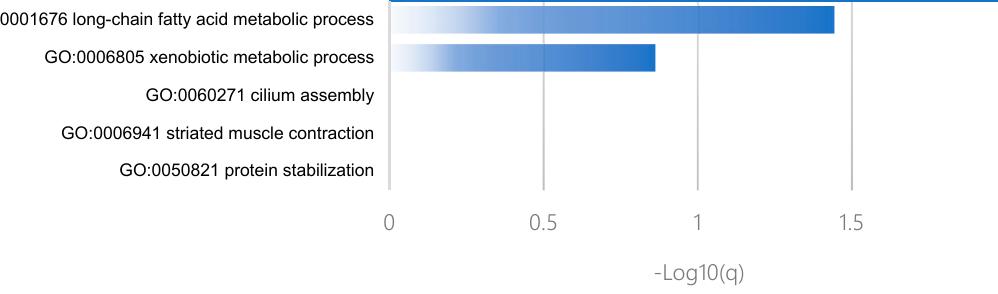
Figure 4. Gene ontology and pathway analysis of upregulated and downregulated proteins in Hacl1 − / − mouse liver. A protein–protein interaction enrichment analysis was performed on differentially regulated proteins. The upregulated proteins mainly form one large cluster associated with peroxisomal protein localisation as part of the peroxisome pathway (Figure 5). Three other clusters are formed associated with the arachidonic acid metabolism, membrane trafficking, and translation (Figure 5).